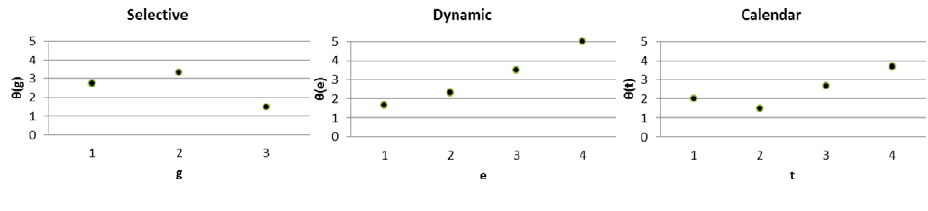
Figure 2. First-level summary measures for the hypothetical group-time ATTs reported in Figure